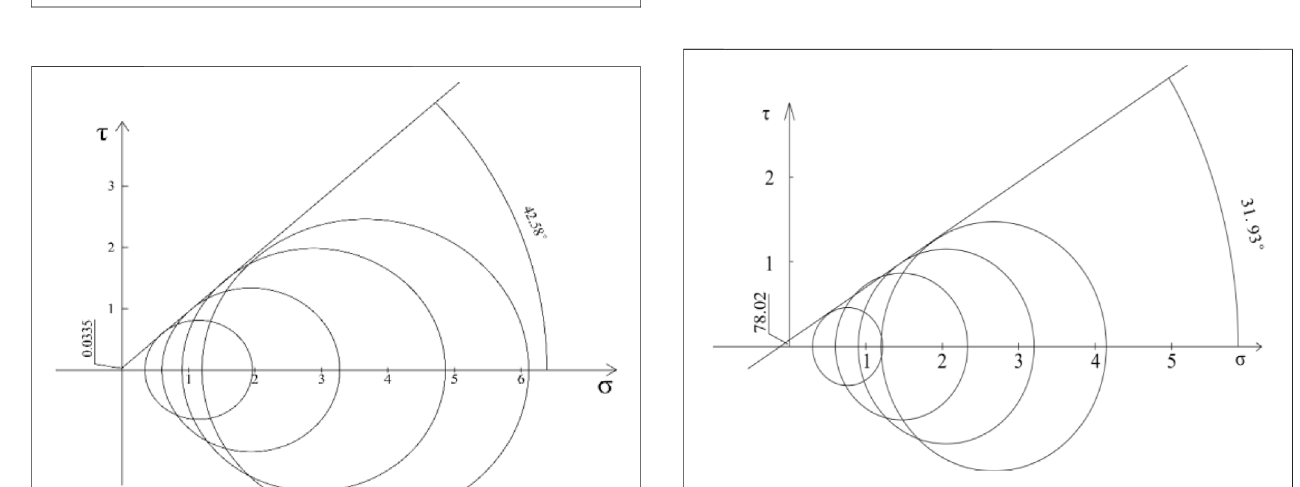
FIGURE 7 | Results of unconsolidated and undrained shear triaxial test of rock-slag and soil mixture diagram.